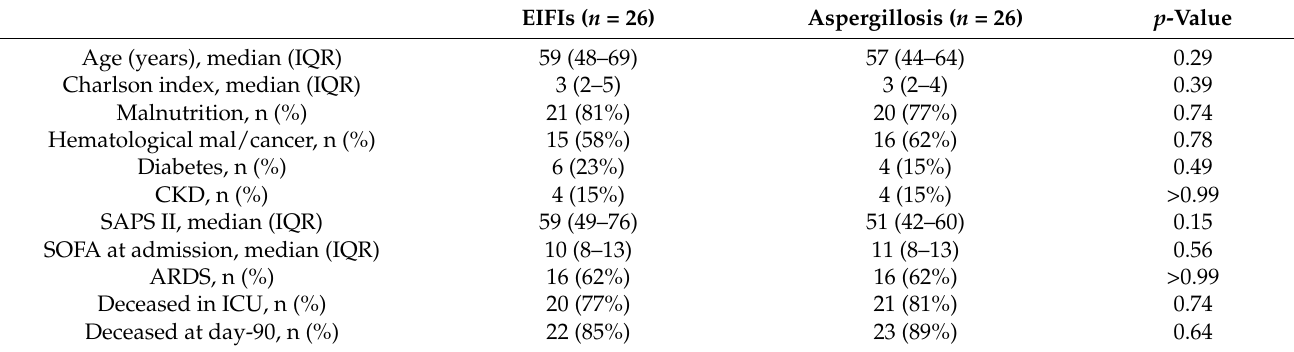
Table 4. Comparison of the EIFI cohort to a matched control group with